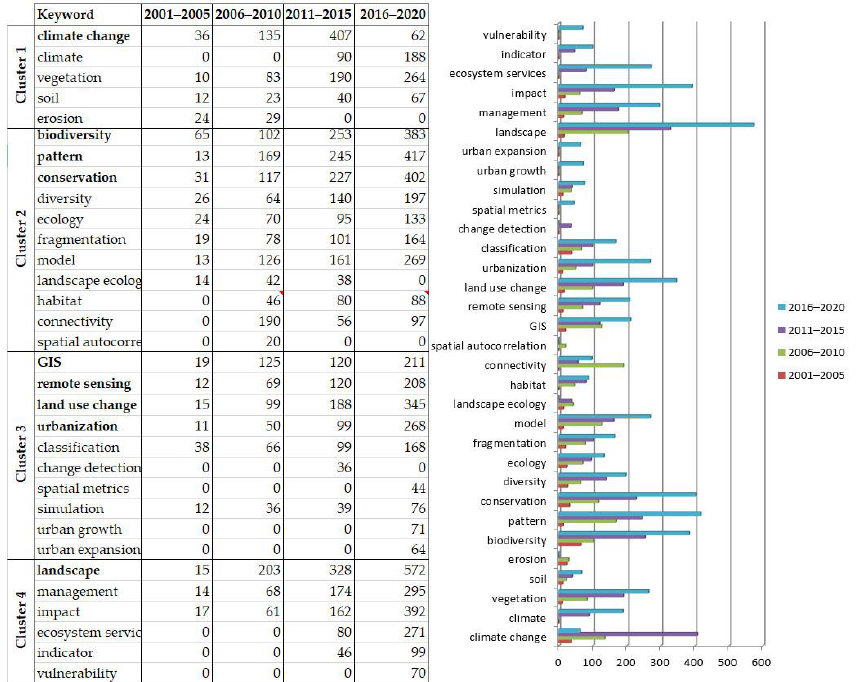
Figure 7. Occurrences and related histograms for the main keywords observed in the 2001 – 2020 period in order to observe their trend in the four periods.